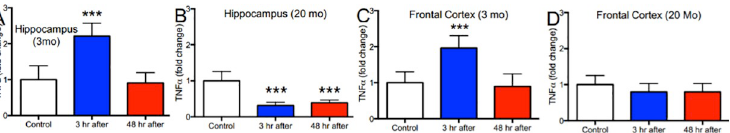
Fig 1. Isoflurane produces age- and region-dependent changes in TNF α gene expression. Mice were anesthetized as described and TNF α measured in the hippocampus and frontal cortex by RT-PCR. TNF α increased transiently in the hippocampus and frontal cortex of young isoflurane anesthetized mice but, like IL-1 β , was persistently reduced in the hippocampus but not frontal cortex of old mice demonstrating age and regions specific effects of treatment with isoflurane on TNF α expression. Data expressed as mean ± SD for N = 6 animals per treatment condition. ��� p < 0.001 relative to age-matched controls by 1-way ANOVA with Dunnett’s test.